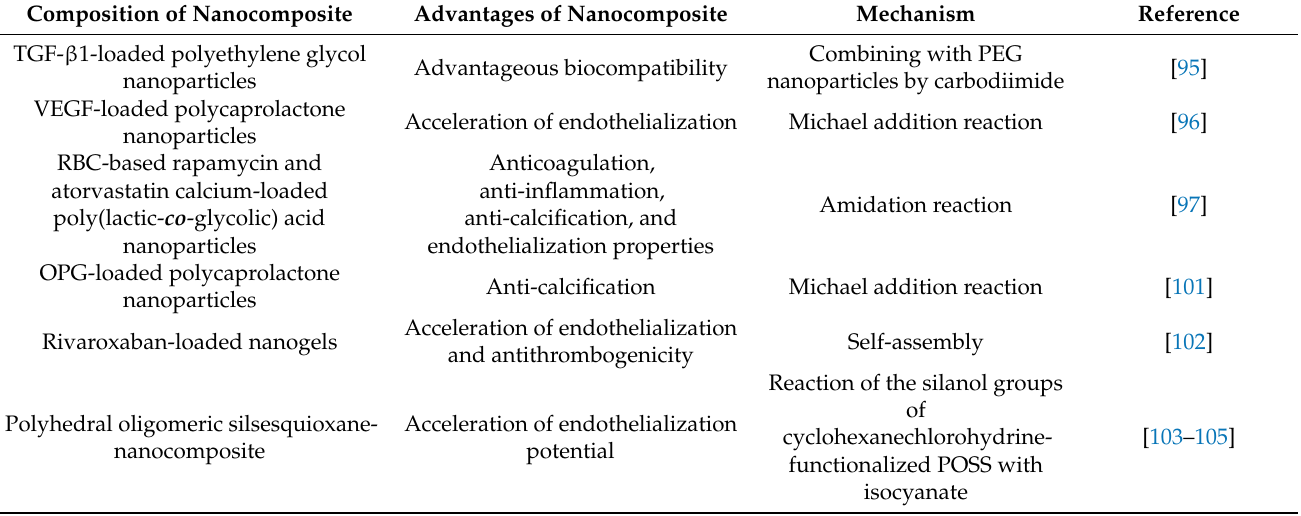
Table 3. Application of different nanocomposites in the study of tissue-engineered heart valves.